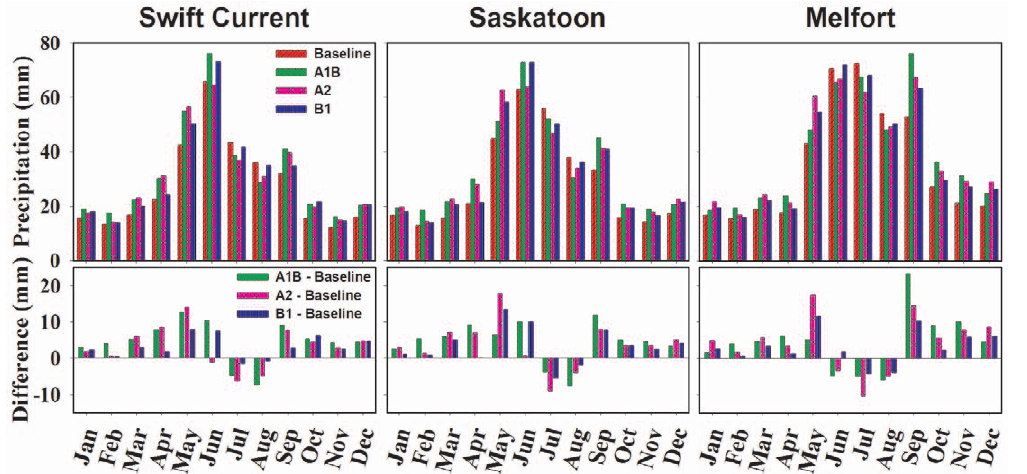
Figure 3. Monthly precipitation under baseline and three scenarios for 2050s, relative to period 1961–1990, and difference between baseline and scenarios.